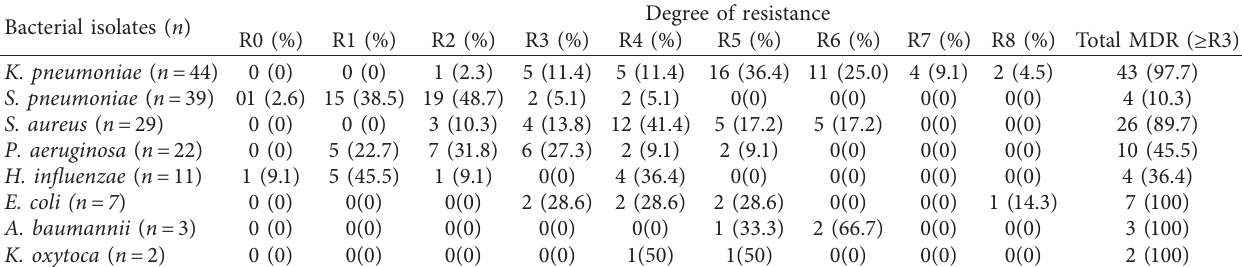
Table 4: Multidrug resistance (MDR) profile of the isolated organisms, Dessie, 2020. Bacterial isolates ( n